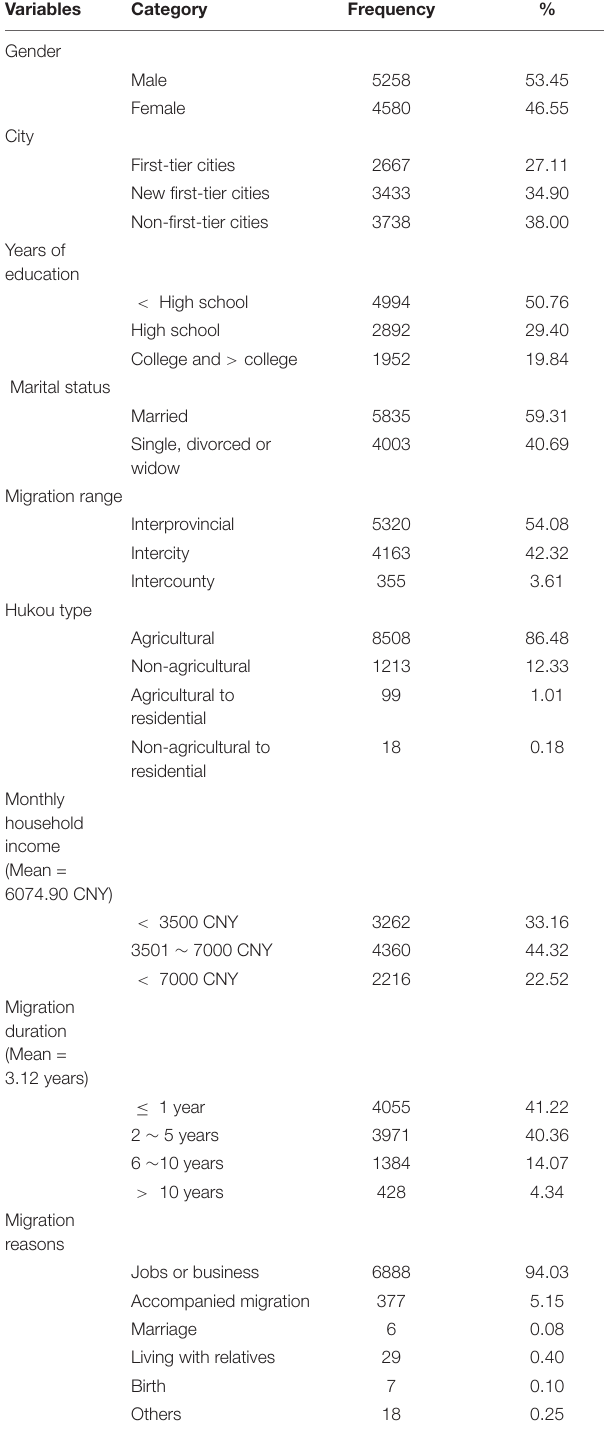
TABLE 1 | Sociodemographic characteristics of the sample ( N =